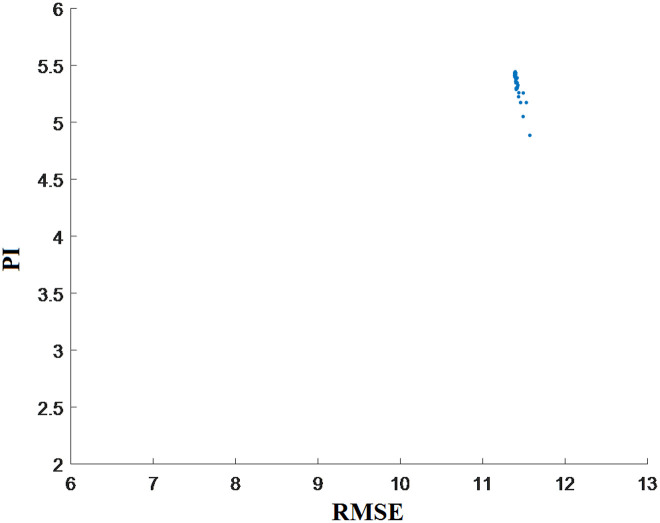
Comparisons of the performance curve of PI versus the RMSE in different weight coefficients of loss components.